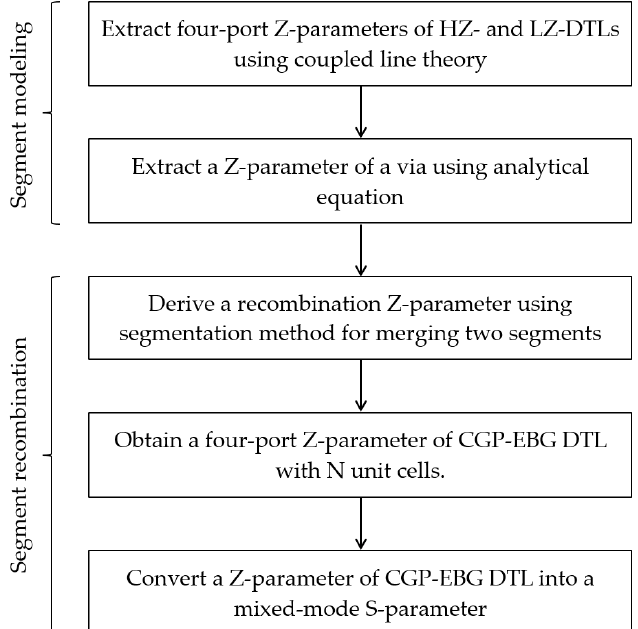
Figure 2. Procedure of proposed analytical method for predicting common-mode (CM) noise suppression and differential signal transmission of CGP-EBG MTM-DTLs.